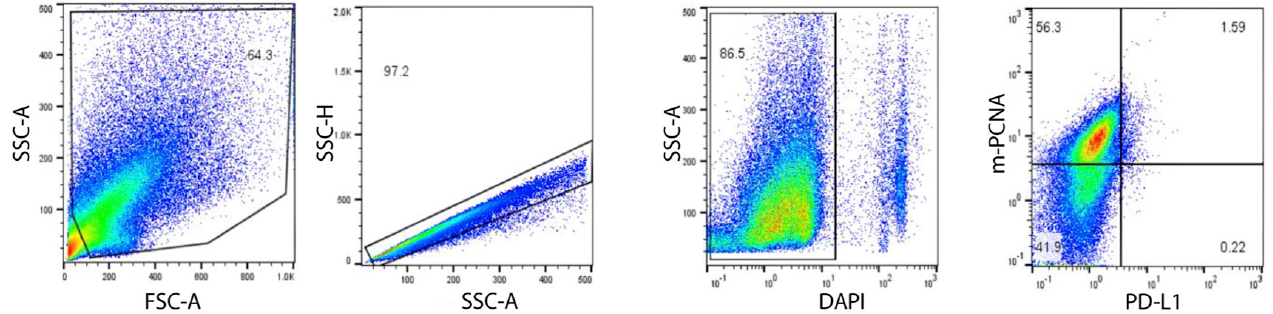
Figure 4. Flow cytometry scheme and representative dotplots (Patient #1) for expression of mem- branal PD-L1 and PCNA (m-PCNA) on digested tumor cells from PDX samples on cell surface.